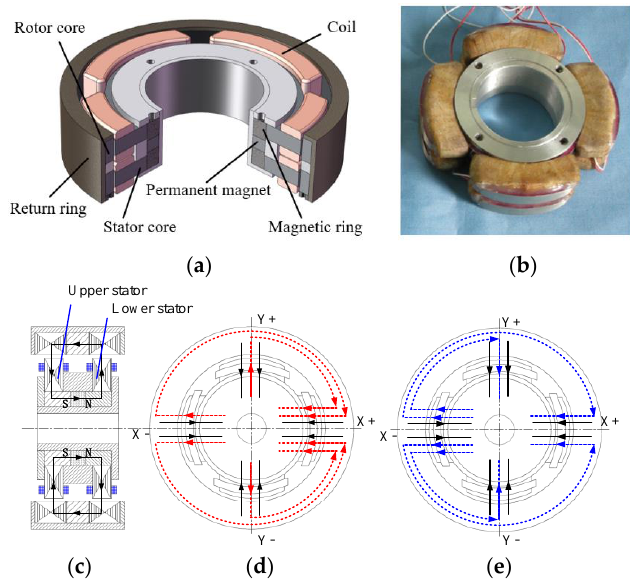
Figure 6. Structure of the AMB. ( a ) Scheme of the AMB structure. ( b ) The stator of the AMB. ( c ) Scheme of the PM magnetic circuit. ( d ) Scheme of the magnetic circuit of X+ winding with positive excitation current (upper stator). ( e ) Scheme of the magnetic circuit of X − winding with positive excitation current (upper